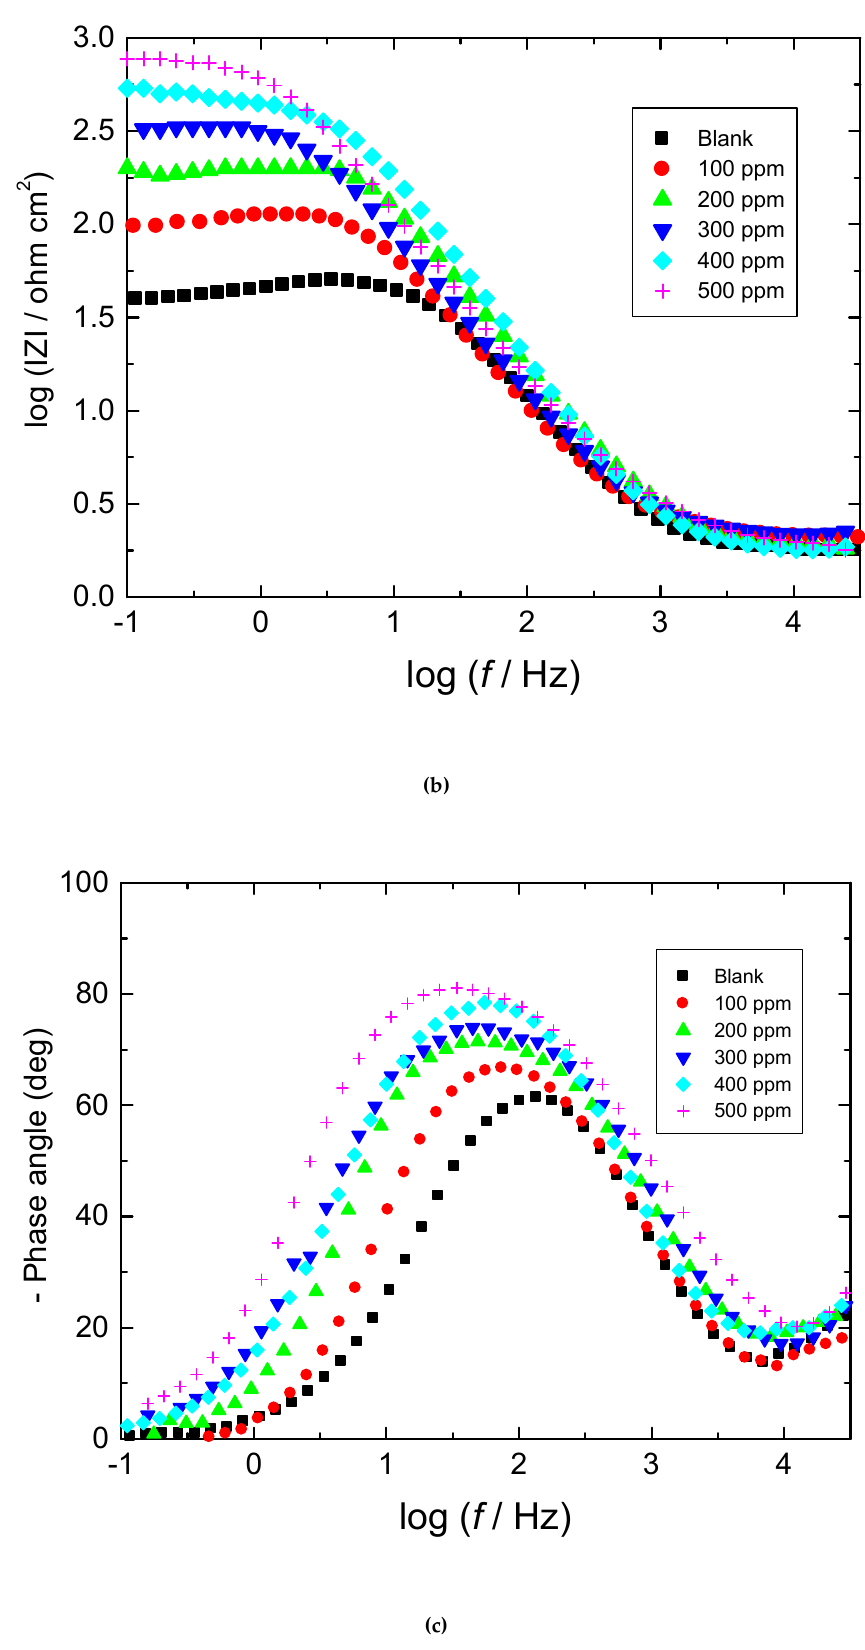
Figure 6. Plots pf: ( a ) Nyquist, ( b ) Bode magnitude, and ( c ) Bode phase for mild steel in 0.5 M HCl solution at 303 K in absence and presence of amylopectin.